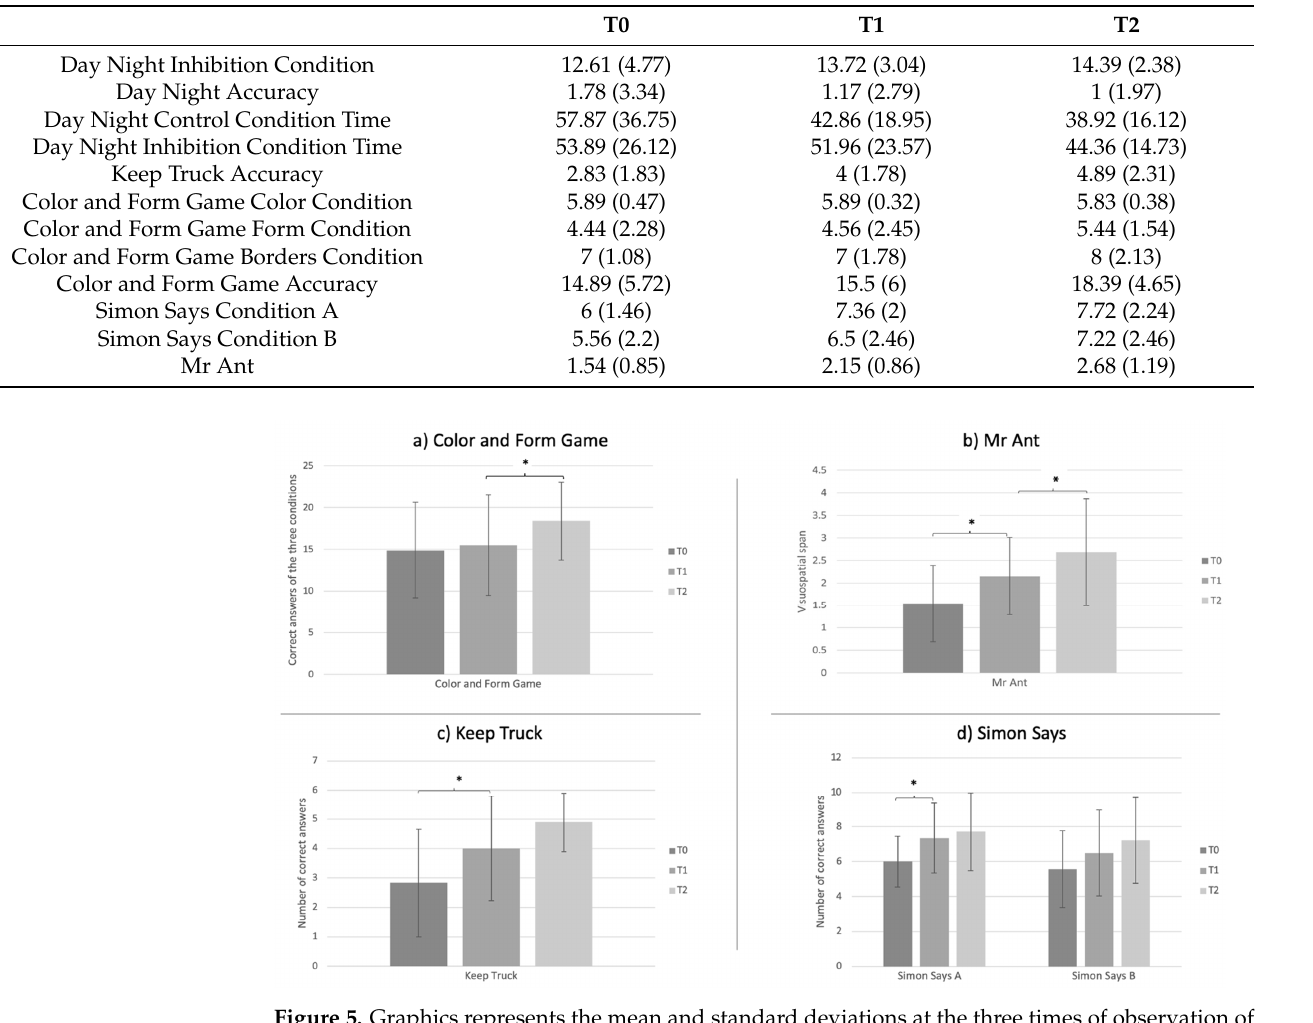
Figure 5. Graphics represents the mean and standard deviations at the three times of observation of the EFs measures showing a significant change between T1-T0 and T2-T1. * significant differences. Table 3. Mean (standard deviation) delta changes during baseline (T1-T0) and experimental (T2- T1) conditions and related effect size in the EFs tests.